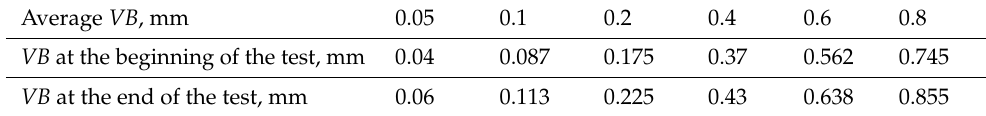
Table 2. Flank wear VB of employed inserts.